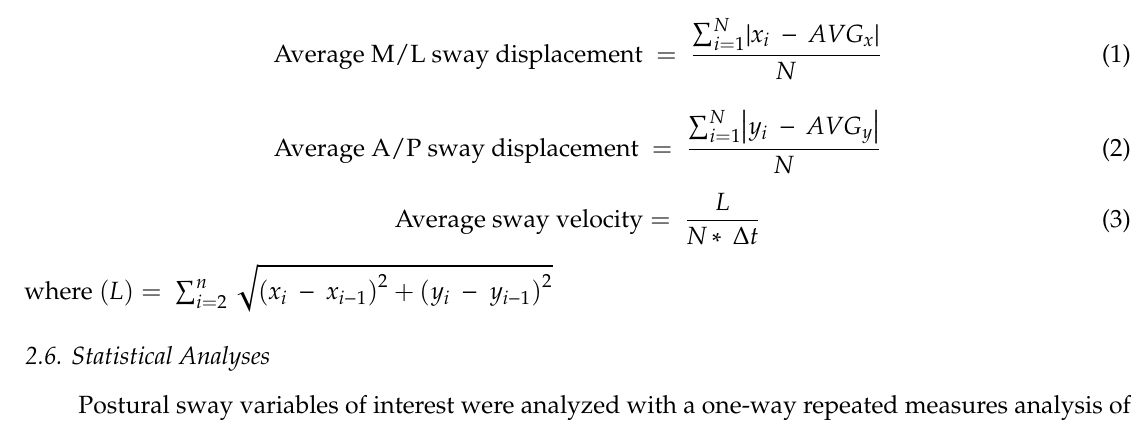
Figure 3. Participant being tested for postural stability wearing a virtual reality (VR) headset.